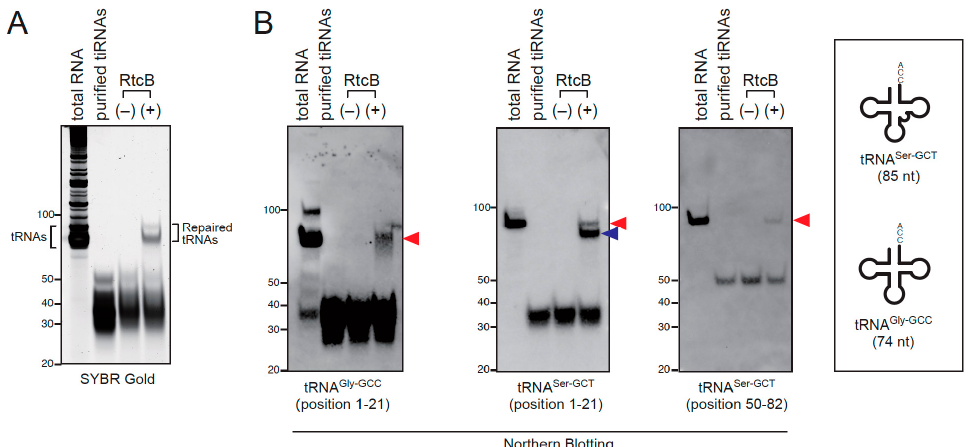
Figure 2. tiRNAs can be repaired to full-length tRNAs by RtcB in vitro. Gel-purified tiRNAs were incubated with bacterial RtcB. ( A ) SYBR Gold staining and ( B ) Northern blotting for tRNA Gly-GCC and tRNA Ser-GCT . The lengths of both tRNA Gly-GCC and tRNA Ser-GCT are also shown. tRNA Ser-GCT is longer than tRNA Gly-GCC because of its long variable loop. Ligation products are indicated by arrowheads. Red arrowheads indicate the ligation products that showed the same mobility as that of the corresponding mature tRNA in total RNA. Note that two bands were detected by the probe for 5 ′ -side (position 1–21) of tRNA Ser-GCT , in contrast to a single band detected by the probe targeting 3 ′ -side (position 50–82) of tRNA Ser-GCT , which suggests that this shorter band (indicated by a blue arrowhead) consists of 5 ′ -tiRNA Ser-GCT and 3 ′ -tiRNAs derived from non-serine tRNAs.